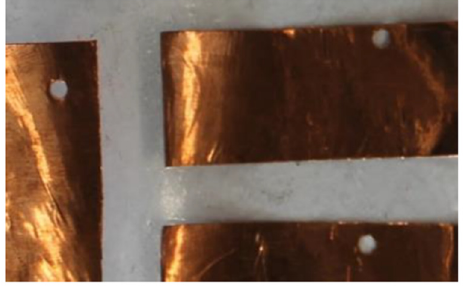
Figure 4. Through holes in the sensor pad for the conductive thread to join with the route layer.